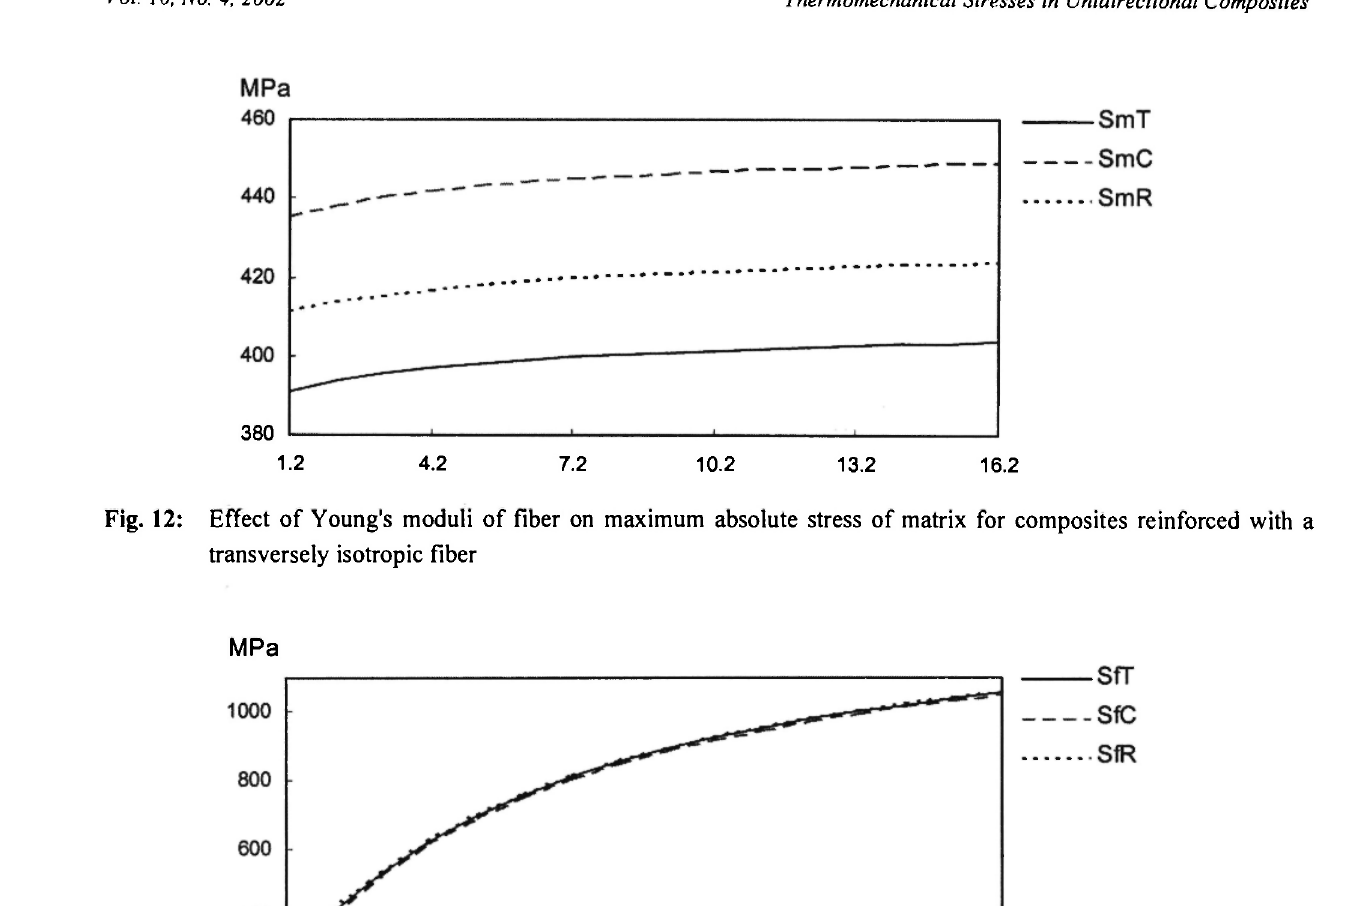
Fig. 13: Effect of Young's moduli of fiber on maximum absolute stress of fiber for composites reinforced with a circumferentially orthotropic fiber